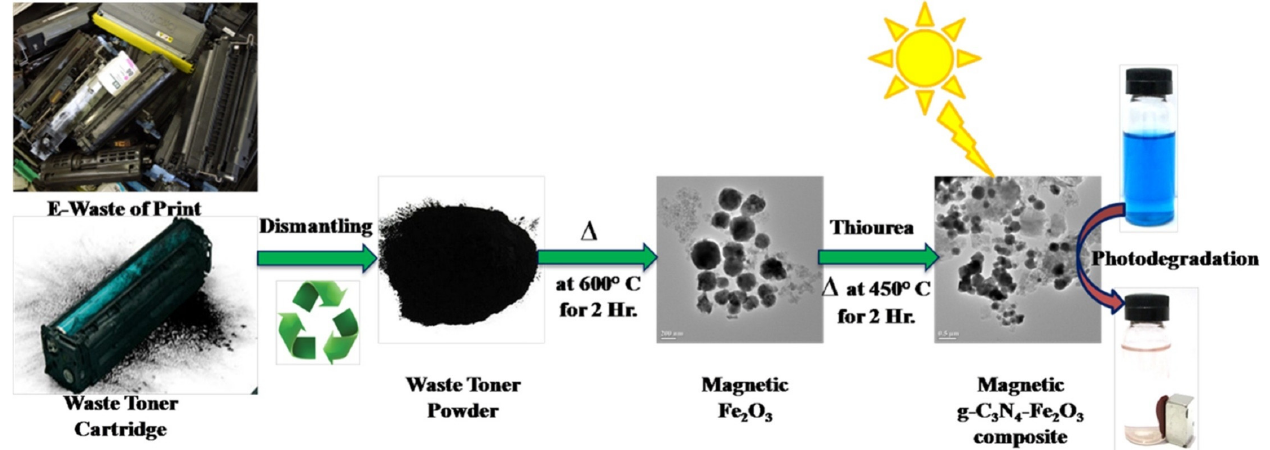
Figure 14. The schematic of the process steps for recycling magnetic g-C3N4-Fe 2 O 3 from e-waste toner powders [164].